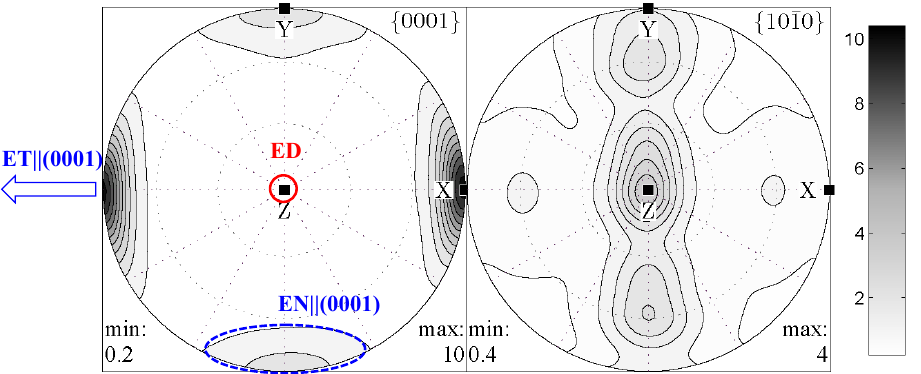
Figure 4. [ 0001 ] and (cid:104) 1010 (cid:105) pole figures obtained from neutron diffraction analysis showing ET ||{ 0001 } plus ED ||{ 0001 } double fiber texture of an AM30 magnesium alloy. The extrusion direction (ED) is along the z-axis with the extrusion transverse direction (ET) along the x-axis and the extrusion normal direction (EN) along the y-axis. The pole figures show high concentrations of [ 1010 ] oriented grains parallel to the extrusion direction [36] (with the permission of Elsevier,